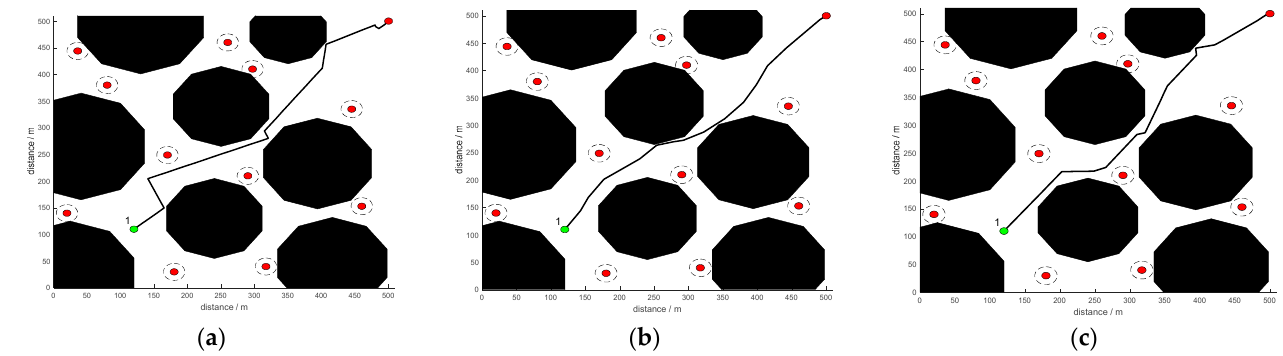
Figure 19. The path results of each algorithm for vehicle No. 1 under Map No. 2. ( a ) is the path result of RRT-connect; ( b ) is the path result of RRT*; ( c ) is the path result of dual RRT optimization.